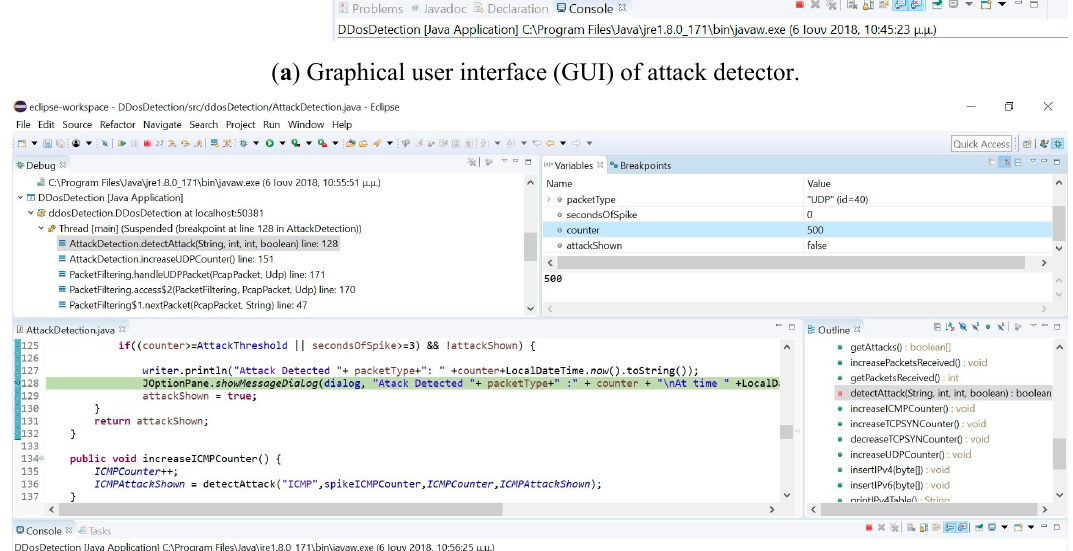
Figure 4. GUI of attack detector and UDP packet with the counter over the threshold that we consider as an attack.